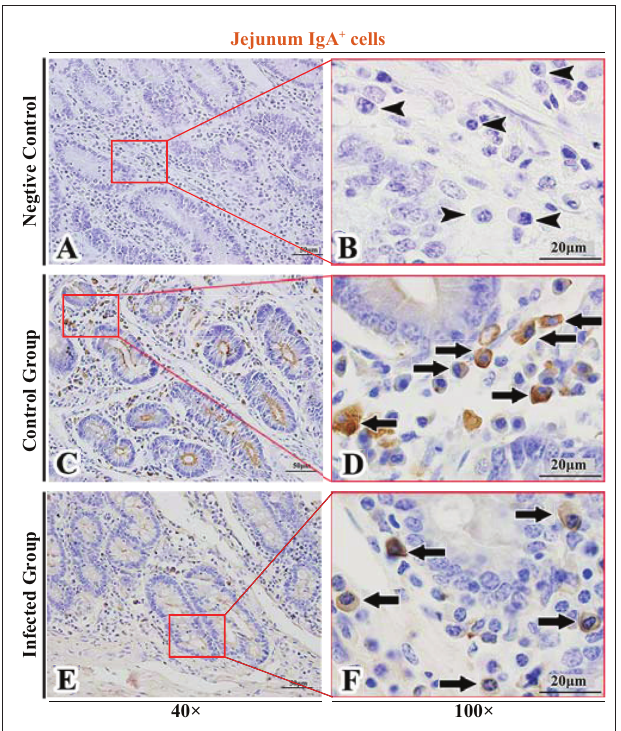
FIGURE 6 | Distribution of IgG + cells in sheep jejunum. (A,B) are negative controls; (C,D) are Control groups; (E,F) are Infected groups. Triangular arrows indicated plasma cells, arrows indicated IgG + cells, and the right image (Scale bar, 20 µ m) is a magnification from the part of the left image (Scale bar, 50 µ m).